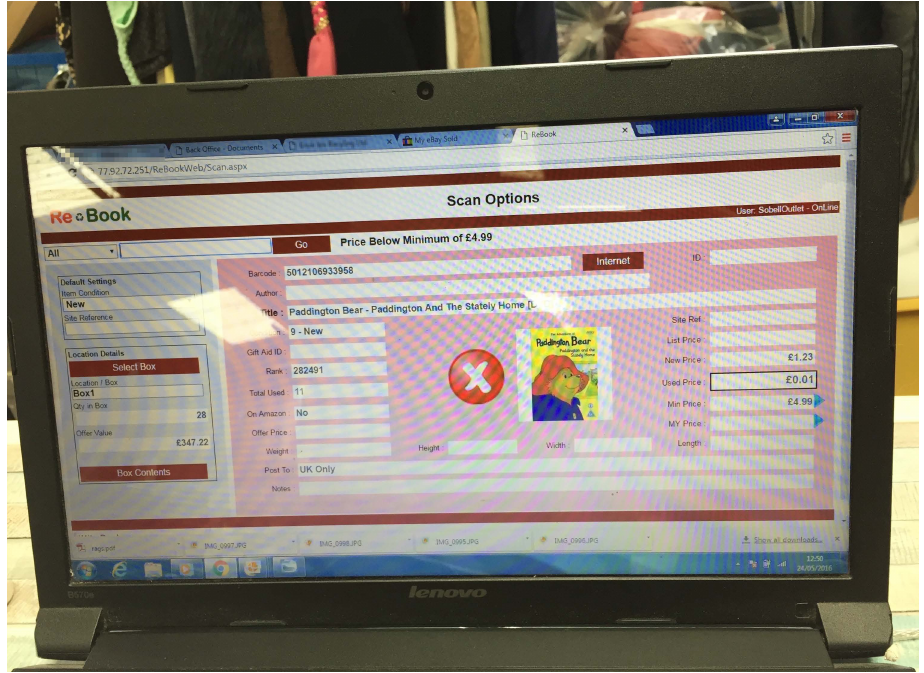
Figure 1. Hospice Charity’s book-scanning software rejects a candidate for online sales. Source: Photo by